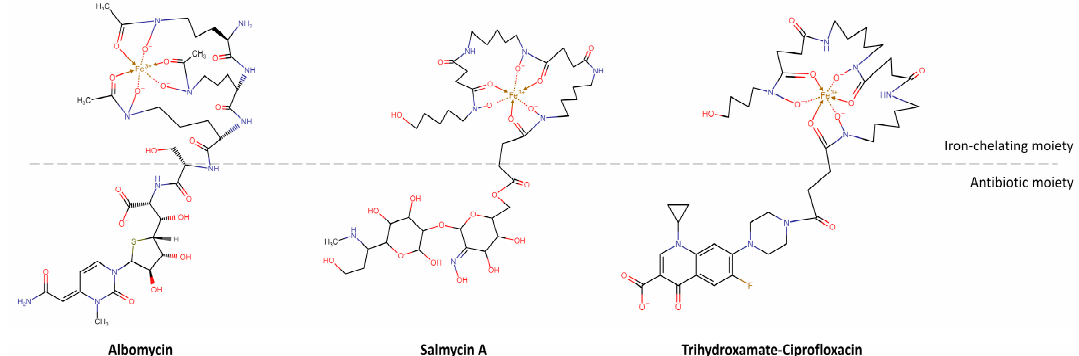
Figure 4. Schematic representation of the state-of-the-art Trojan horses (adapted from [261,262]). The chemical structures were drawn with Chemicalize.